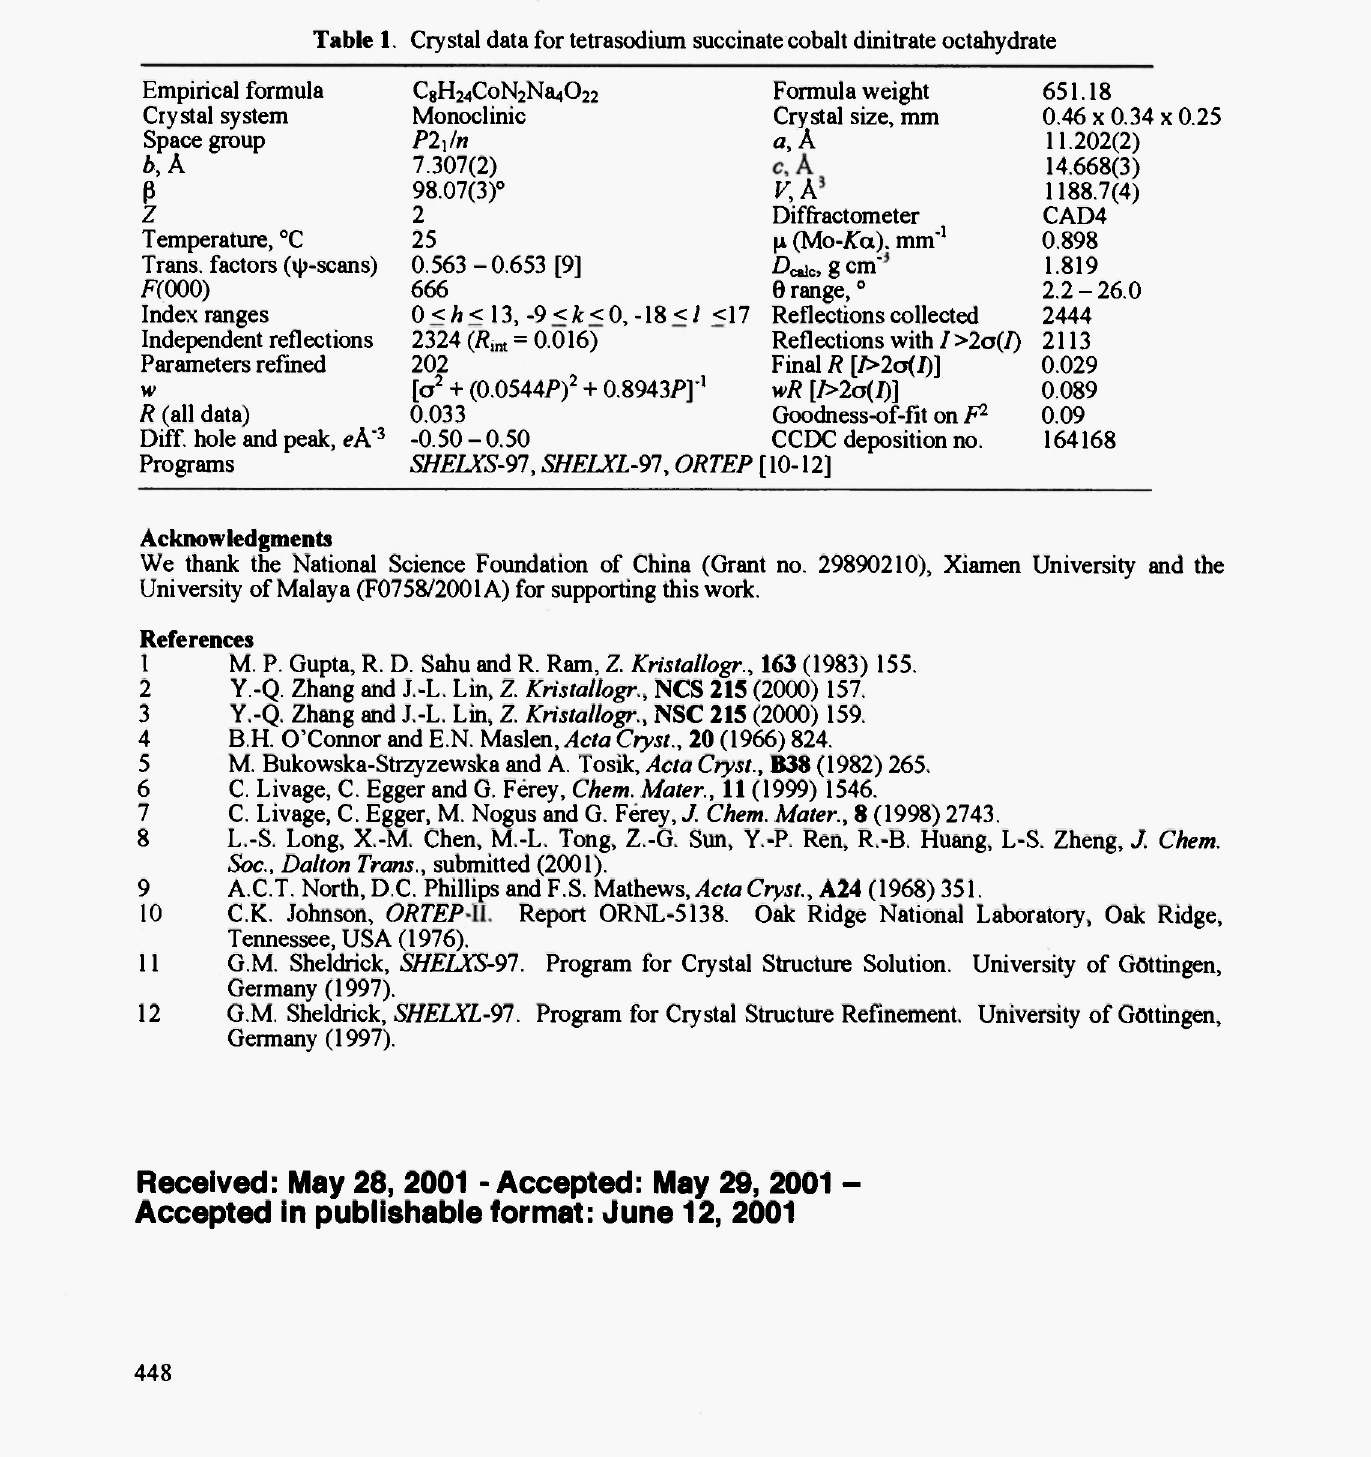
Table 1. Crystal data for tetrasodium succinate cobalt dinitrate